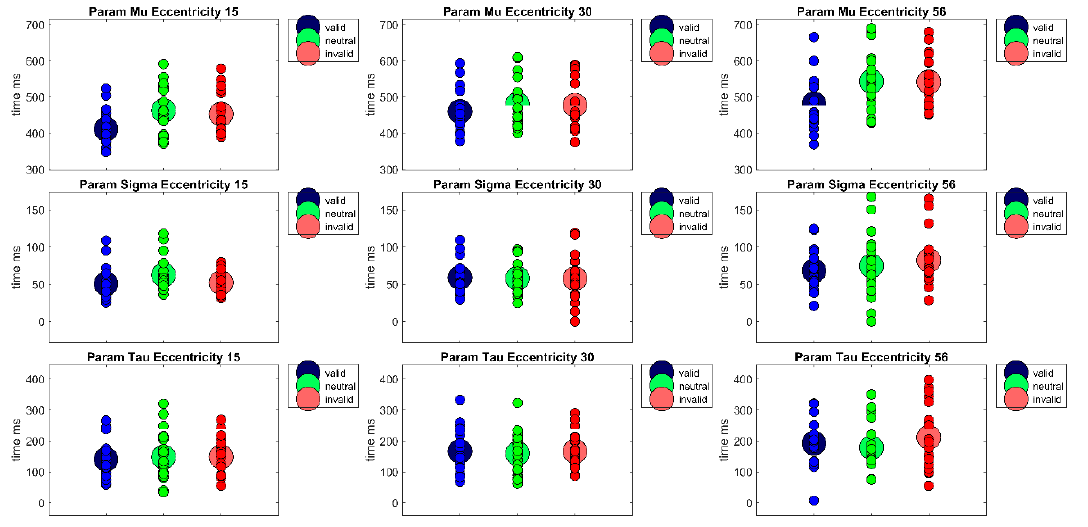
Figure 4. The figure shows the parameters of the ex-Gauss-fit ( µ , σ , τ ) for each Eccentricity (15 ◦ , 30 ◦ , 56 ◦ ) × Cueing (valid, neutral, invalid) condition. Large circles show the condition mean and small circles show the values of each individual participant.